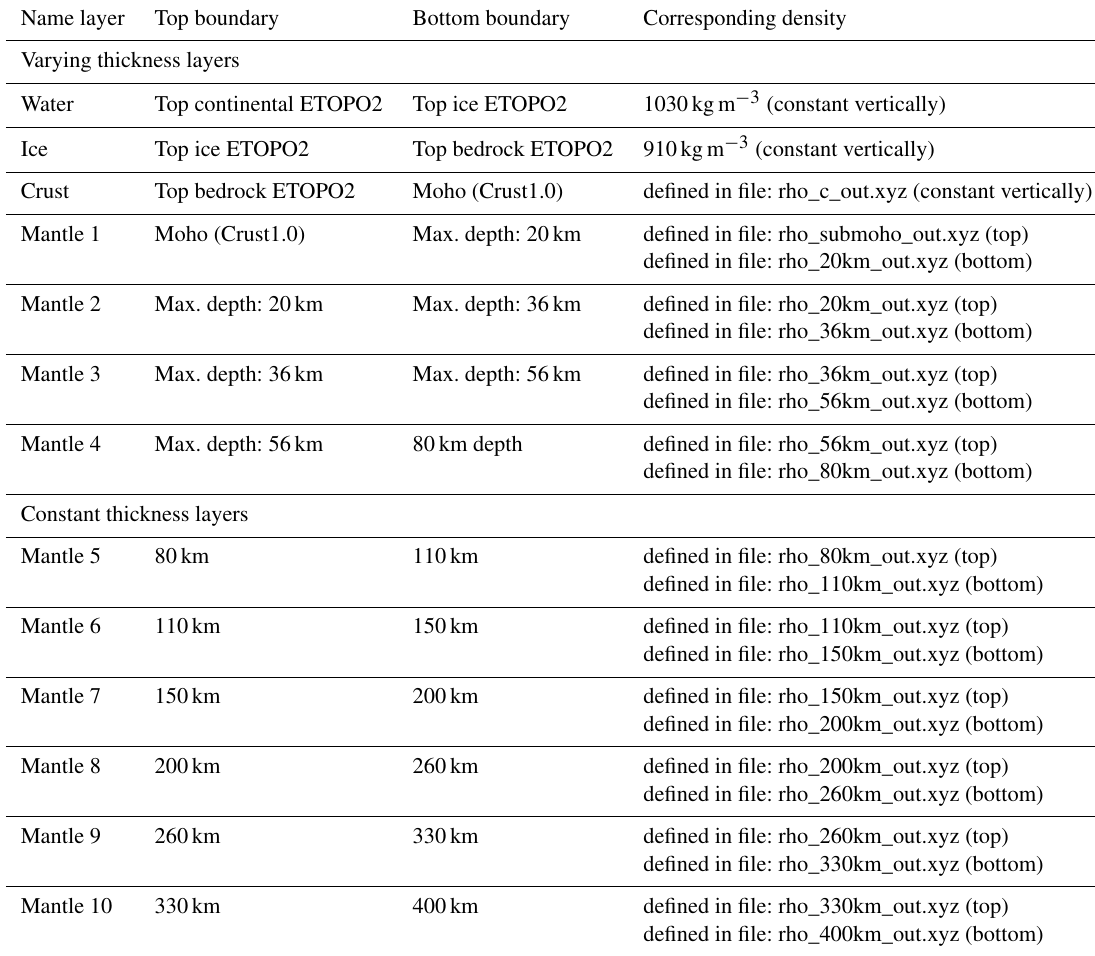
Table C1. The WINTERC-G layering structure used in this